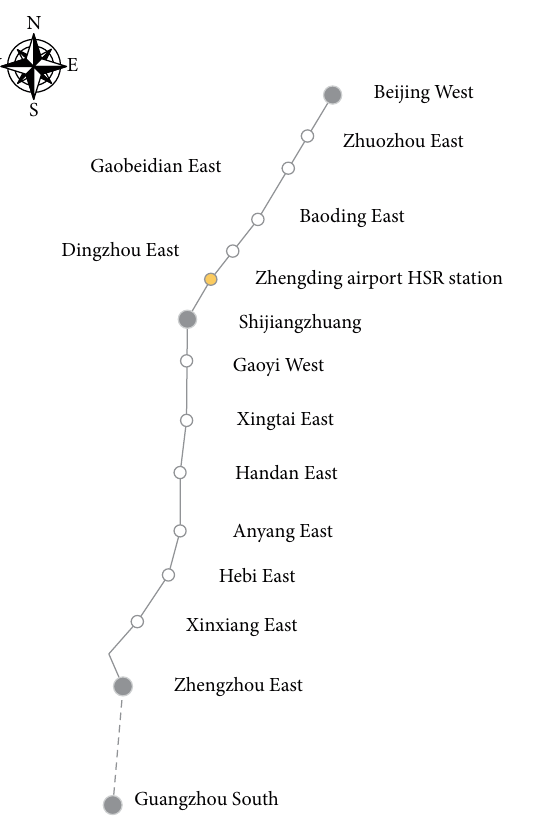
Figure 4: Track layout of the HSR line section between Beijing and Zhengzhou.